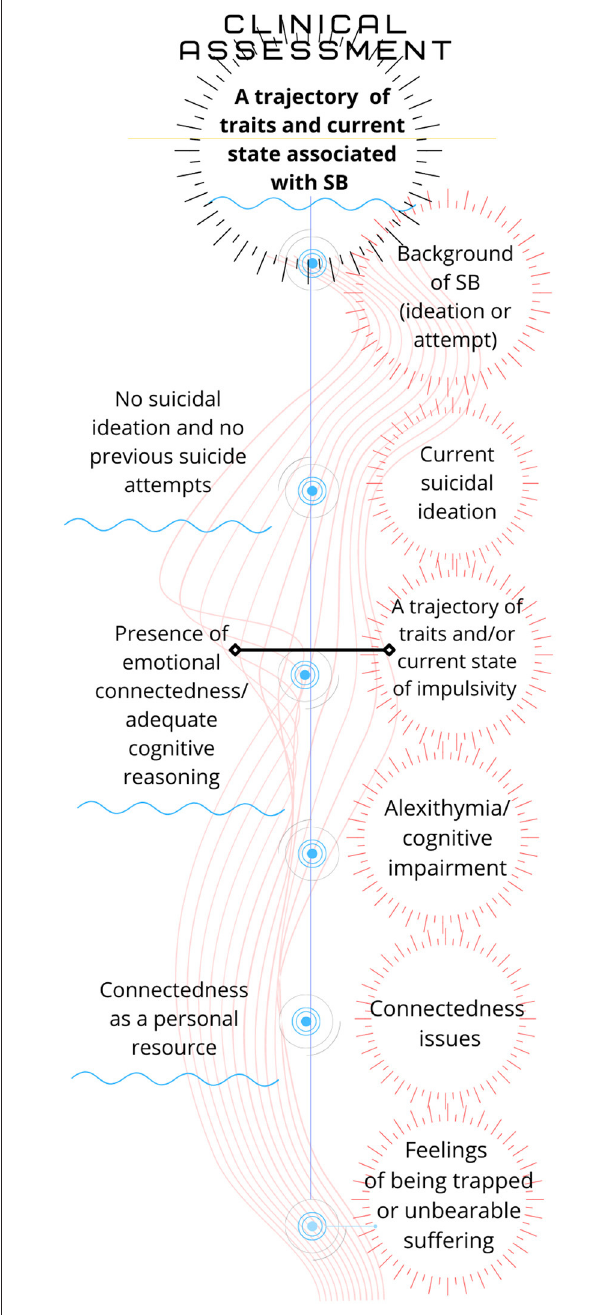
FIGURE 4 | Clinical assessment.